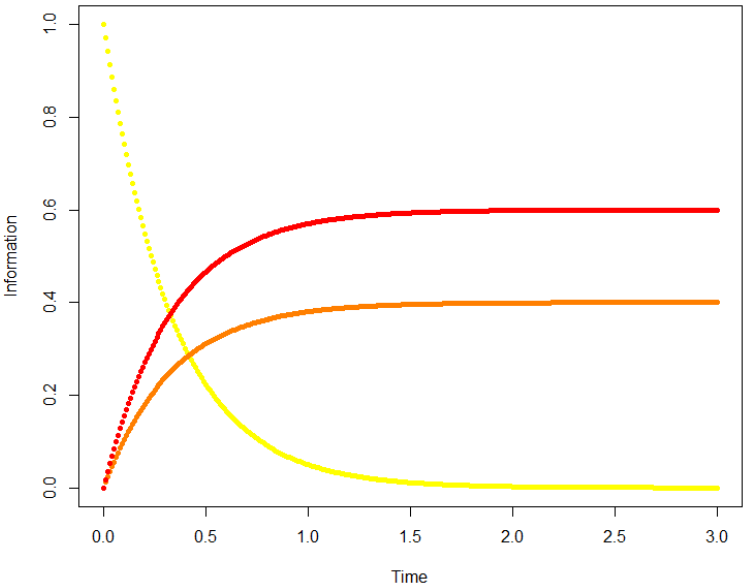
Figure 14. A 3 node-graph. Node 1 gives information to node 2 (resp. 3) with rate 0.4 (resp. 0.6). There is no delay, and D =